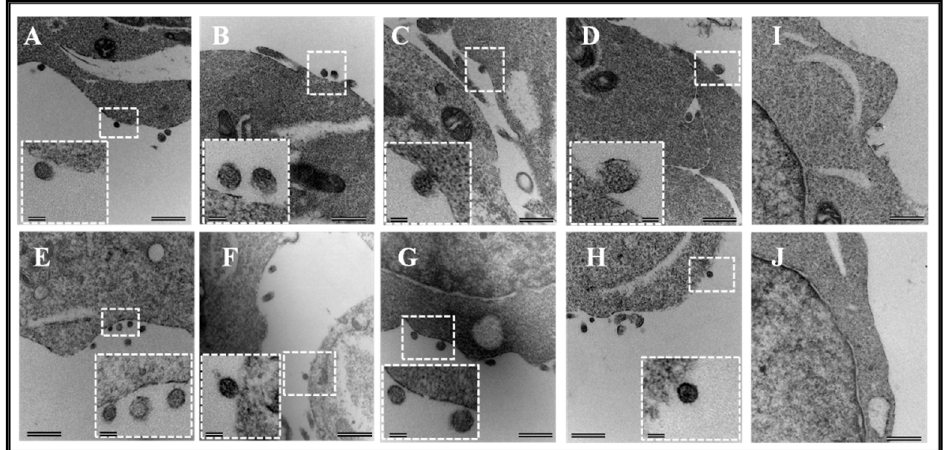
Figure 2. Assembly and budding of virus-like particles (VLPs) by full-length FIV Pr50 Gag in eukaryotic cells. The transfected 293T cells (~ 60 hours following transfection) were fixed for electron microscopy. Characteristic images of VLPs resembling immature virions budding as well as intermediates associated with the plasma membrane are shown when AD2 (full-length FIV Pr50 Gag expression with His 6 -tag) ( A – D ) and AD3 (full-length FIV Pr50 Gag expression without His 6 -tag) ( E – H ) were transfected into 293T cells. No budding of VLPs was observed when the cells were transfected with the eukaryotic expression vector alone, pcDNA3, as a negative control ( I , J ). Areas from where electron micrographs were taken at higher magnification are demarcated as dashed boxes and shown within the pictures as insets. Scale bars represent 500 nm (26,500 × magnification) for the wide-field pictures and 100 nm (87,000 × magnification) for the insets, respectively.